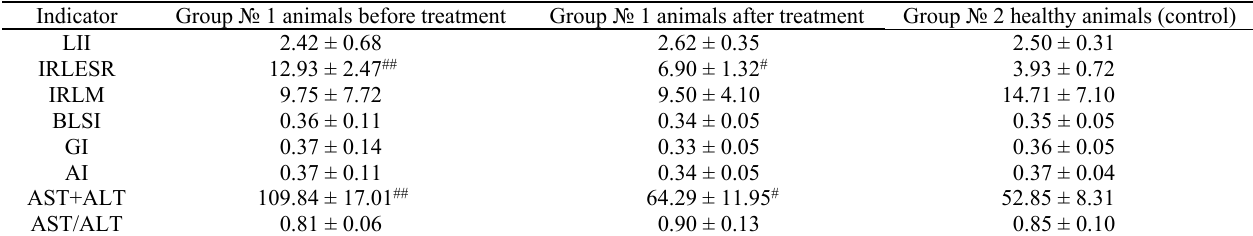
Values of integral indicators of the German Shepherd dogs ( М ± m, n = 10) Indicator Group № 1 animals before treatment